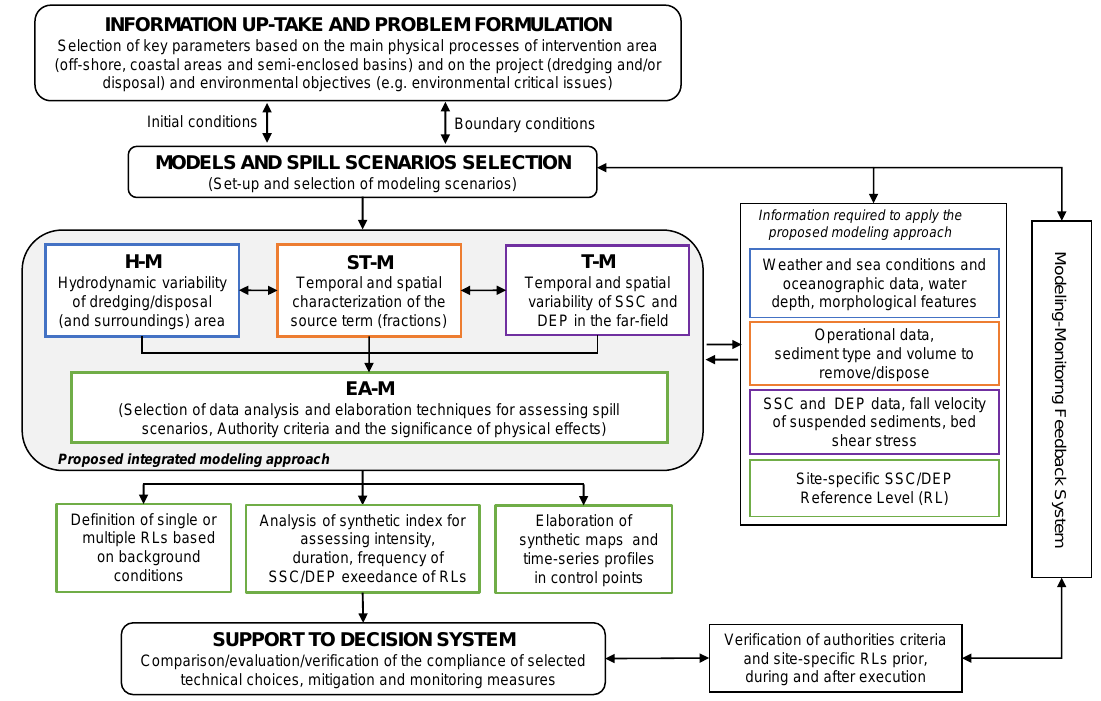
Figure 1. Flow chart of the proposed methodological approach.